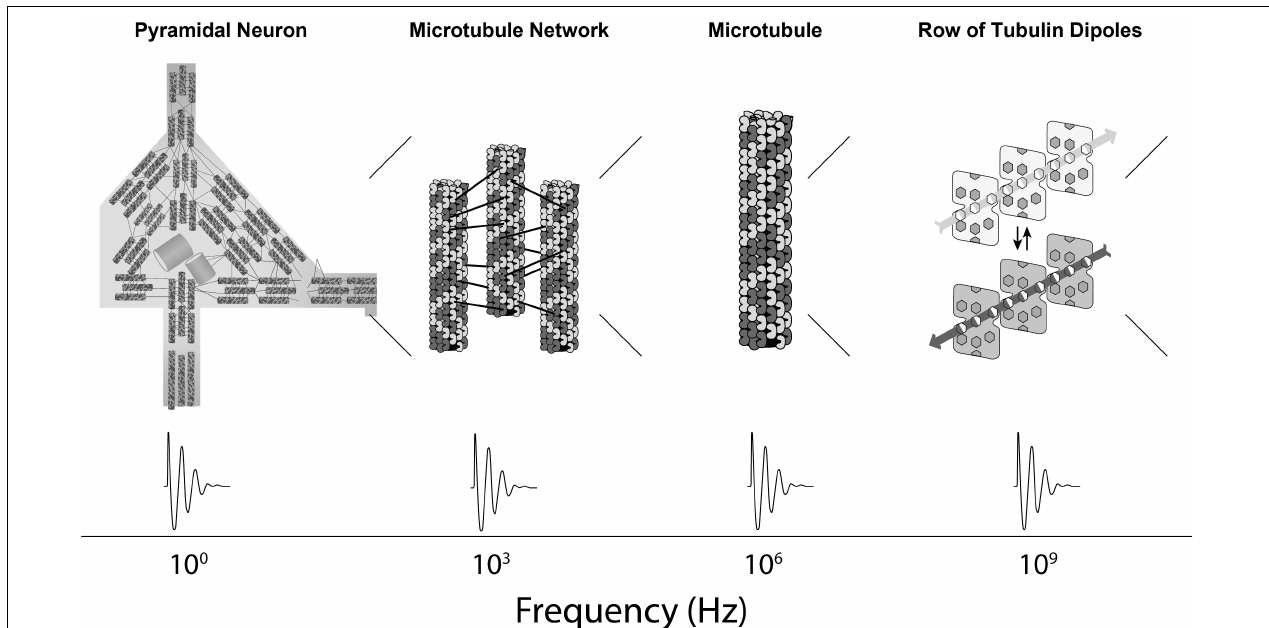
FIGURE 1 | First part of a proposed spatiotemporal hierarchy in which Orch OR-mediated consciousness can occur, starting here inward from the level of neurons: From left to right, a cortical pyramidal neuron showing internal networks of mixed polarity microtubules, a network of mixed polarity microtubules, a single microtubule, a row of tubulins within a microtubule with schematic display of collective dipoles among pi electron resonance rings. Below—frequency dynamics at relevant scales.